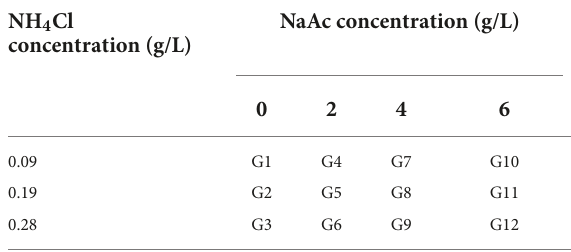
TABLE 1 The design of two-factor